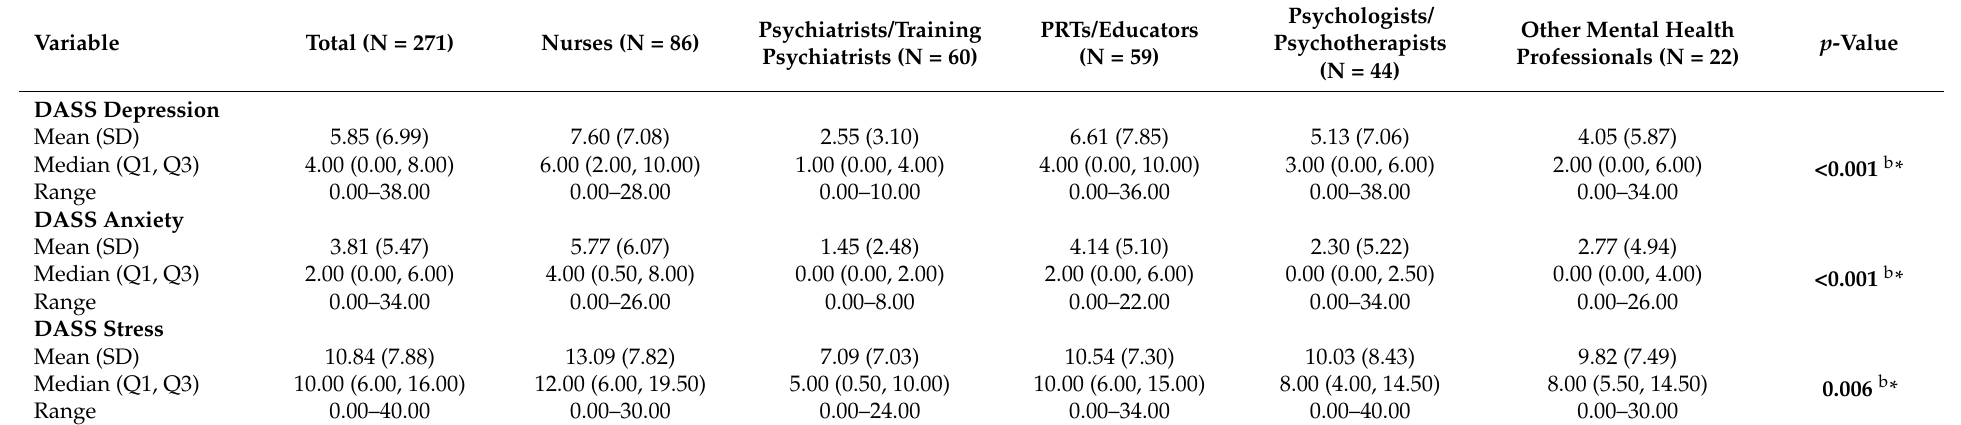
Table 4. Descriptive statistics on DASS-21 subscales stratified by type of professional